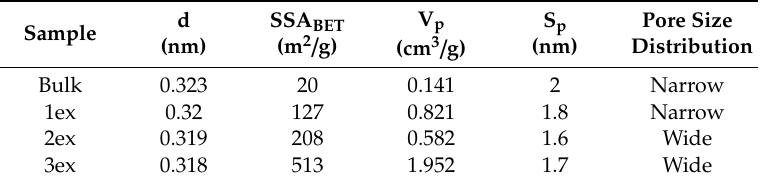
Table 1. Distance (d), specific surface area (SSA BET ), total pore volume (V p ), main pore size (S p ), and pore size distribution.